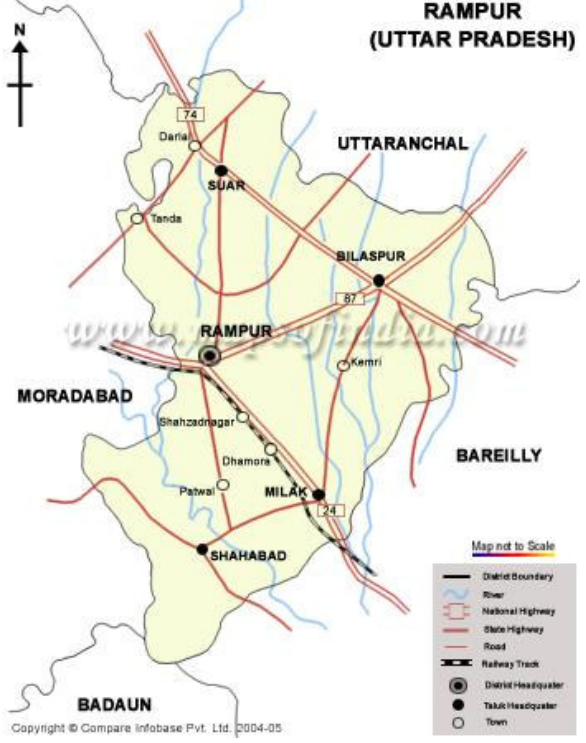
Figure 1. Map of Rampur